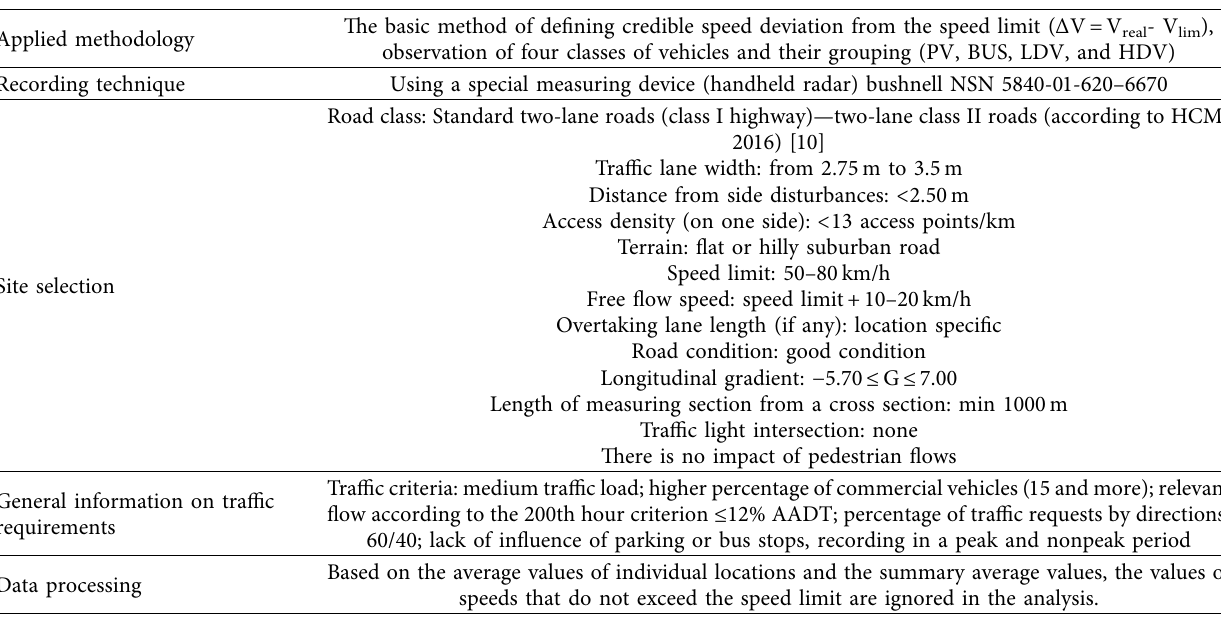
Table 1: Criteria for obtaining the values of a credible deviation from the speed limit.